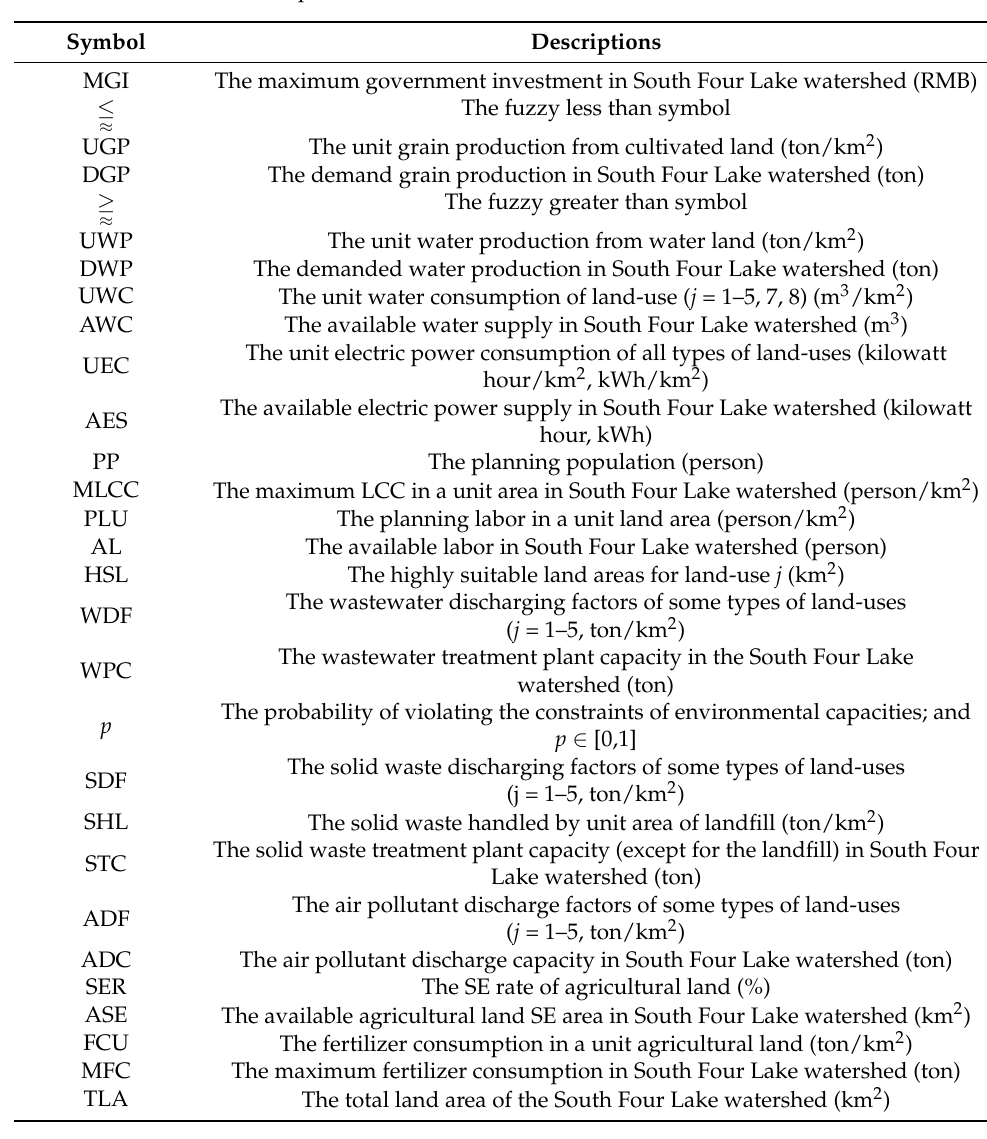
Table A1. Nomenclature for parameters and variables.